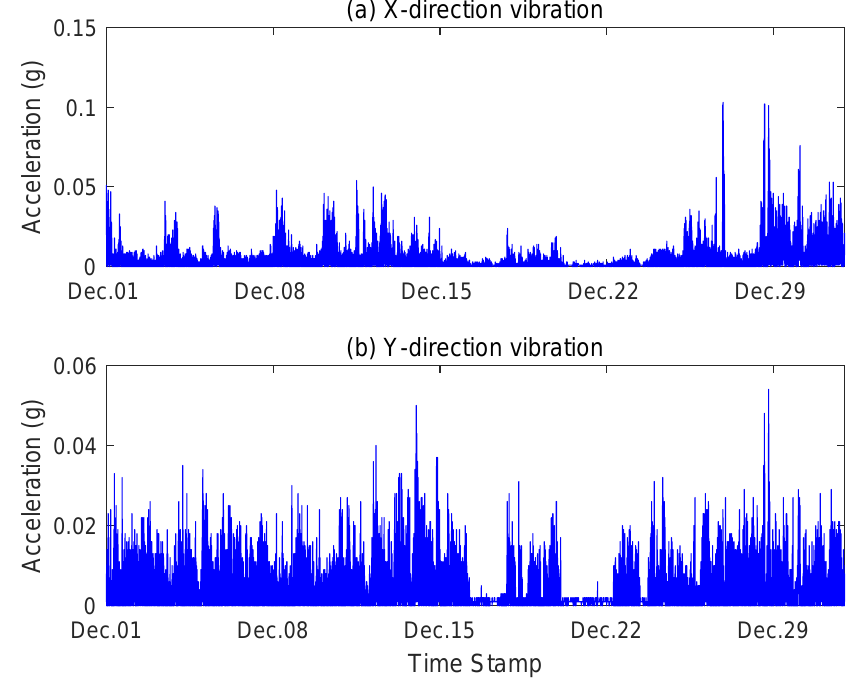
Figure 2. Wind turbine gearbox vibration signals from ( a ) X direction ( b ) Y